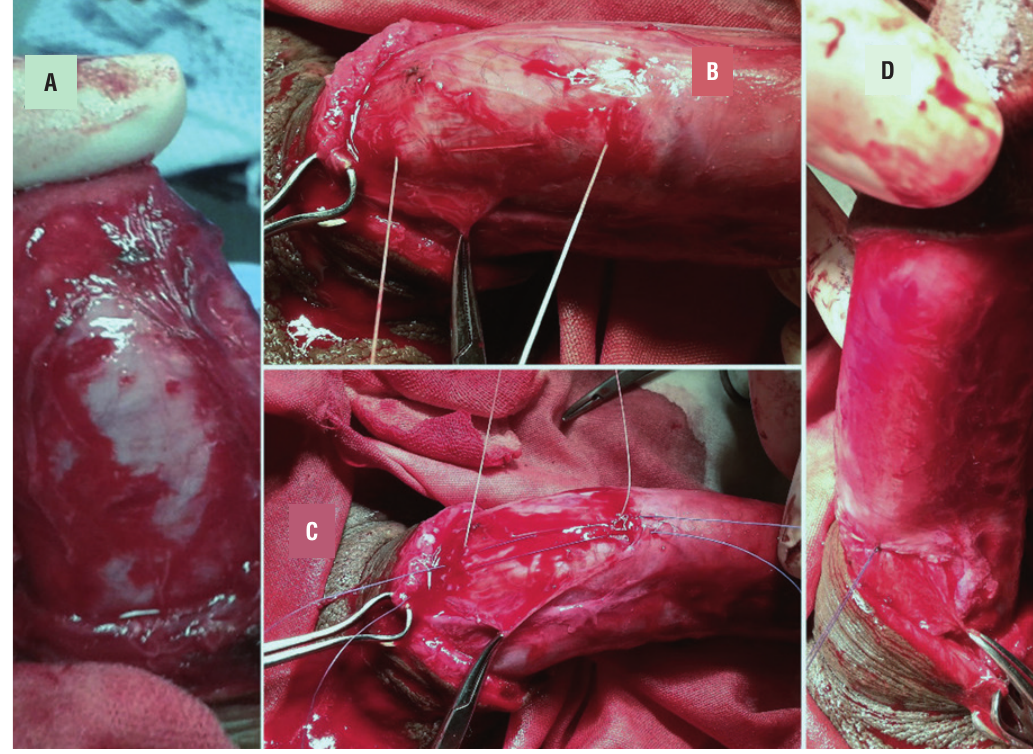
Figure 2 - steps of CPI technique. 2A) Two transverse incisions through outer layer of tunica albuginea at first and last dots. 2B) Ethibond suture passing through interior edges of the incisions and plicating the intermediate 2 dots. 2C) vicryl suture passing through outer free edges of the incisions. 2D) Tightening and ligation of the Ethibond sutures followed by closure of outer edges over ethibond suture